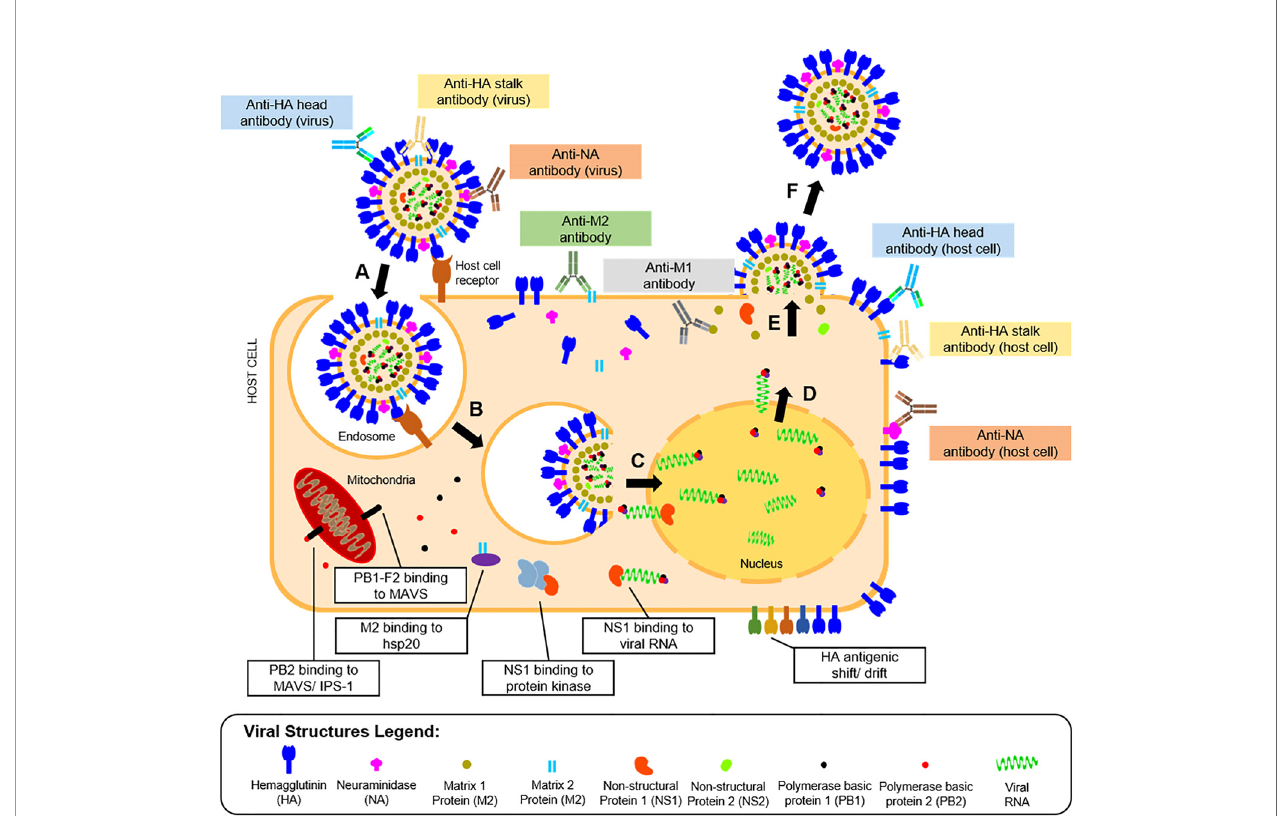
FIGURE 2 | Life cycle, humoral immunity targets, and immune escape mechanisms of in fl uenza viruses. The in fl uenza infection starts with (A) the attachment of the viral HA protein to terminal sialic acid residues of host cell receptors on mucosal membranes. The process is followed by (B) endocytosis of the virus, where an endosome is formed inside host cells. The endosome is then acidi fi ed causing (C) fusion of the viral HA with the endosomal membrane and release of viral proteins and genome into the host cytoplasm. The viral genome is transported to the host cell nucleus, where it is (D) transcribed to messenger RNAs and eventually translated to viral proteins for progeny virions. (E) The viral proteins undergo post-translational modi fi cation at the host cell ’ s Golgi apparatus, eventually get packaged into progeny virions, and are then (F) released by budding from the host cell membrane where viral surface proteins are expressed. In fl uenza proteins expressed in different phases of the viral life cycle serve as targets for the humoral immune response (colored boxes). The most reported antibodies in in fl uenza A are those targeting the HA head and stalk and the NA expressed in the released virions. However, other antibodies targeting the host cell-bound HA head and stalk, NA, M1, and M2 were also reported. The viral escape response from the host ’ s immune system was also described (white boxes), which include viral protein binding to cellular enzymes, and modi fi cation of viral protein